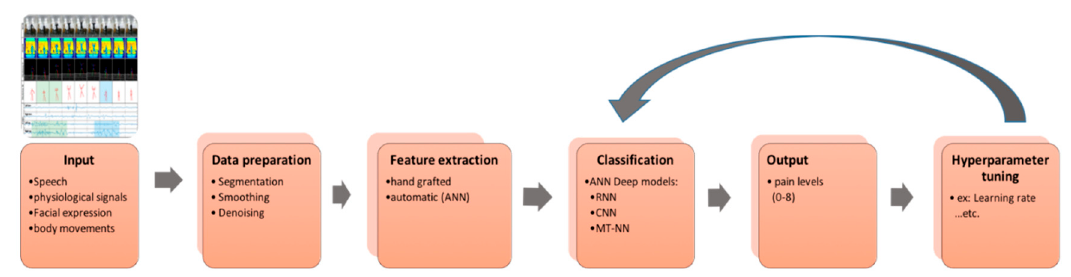
Figure 2. Flowchart of deep-learning-based pain-recognition methods.